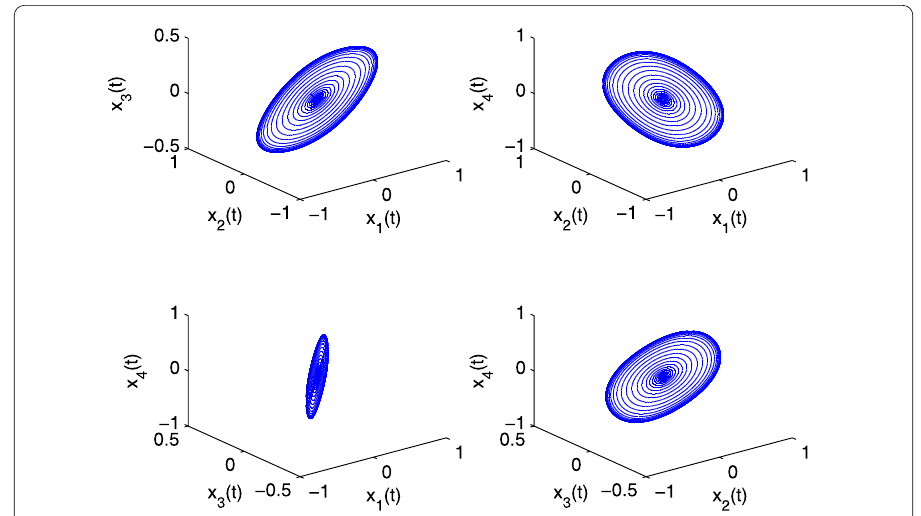
Figure 17 Phase portrait of system (5.4) with φ = 0.96, τ = 0.28 > τ 0 = 0.2427